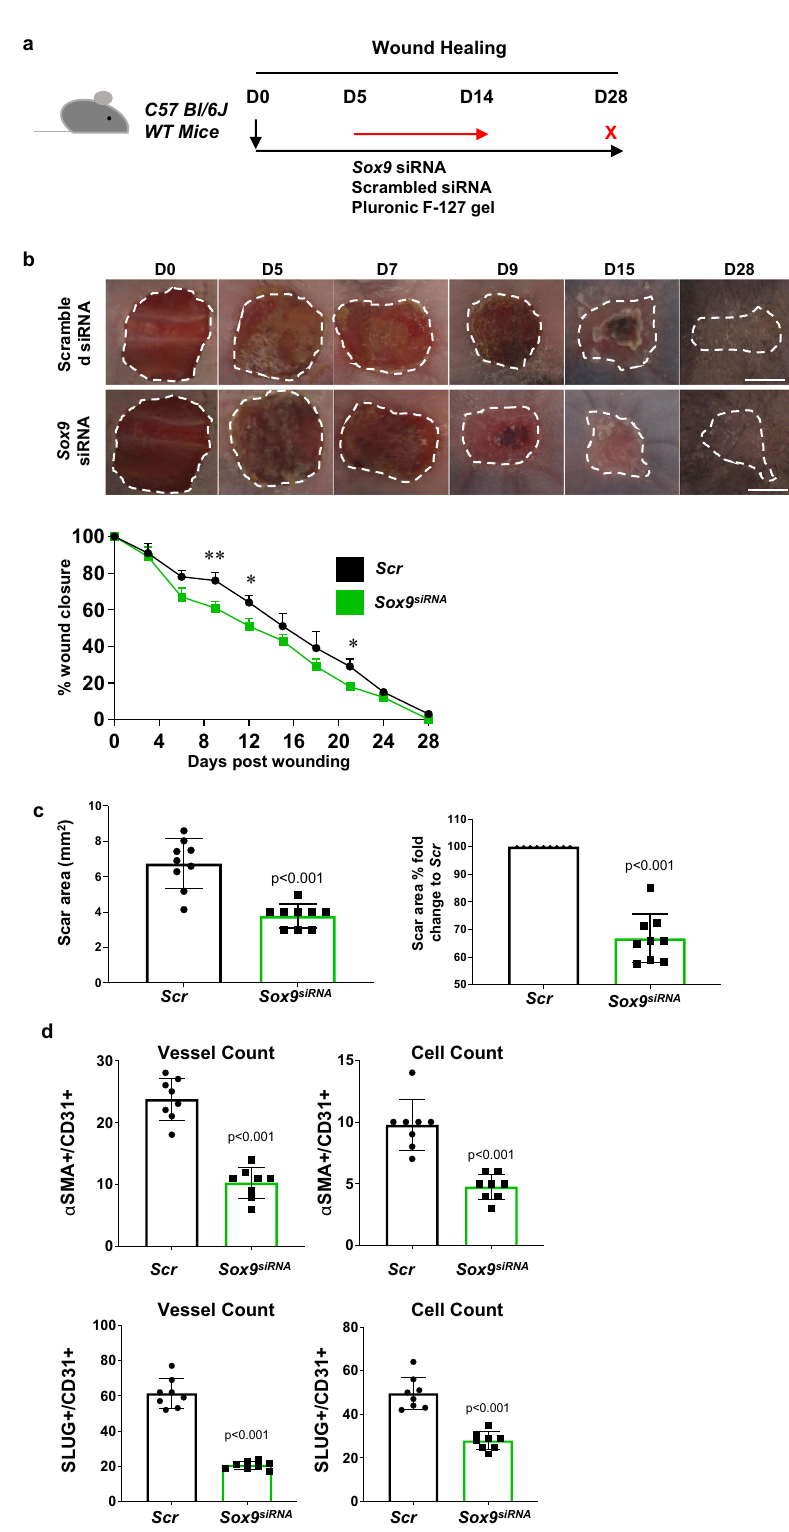
Fig. 8 Reduced scarring upon use of siRNA to inhibit Sox9 in wound healing. a Schematic diagram demonstrating experimental set up using wild-type mice. b Photo images showing wound healing over the course of 28 days (D28) post wounding between scrambled ( Scr ) controls and Sox9 siRNA ( Sox9 siRNA ) treated mice. Signi fi cant increase in wound healing was observed in mice treated with ( Sox9 siRNA ) compared to Scr (* p < 0.05; ** p < 0.01 vs Scr ; n = 8 biologically independent animals; mean ± SD; p value was calculated by two-way ANOVA with multiple comparison of row mean). c Signi fi cant decrease in macroscopic scar area was observed in mice treated with ( Sox9 siRNA ) compared to Scr (** p < 0.01 vs Scr ; n = 8; mean ± SD). d Quanti fi cation of skin wound sections at day 7 (D7) with endothelial markers CD31 and EndMT markers SLUG and α SMA (** p < 0.01; *** p < 0.001 vs Scr ; n = 5 biologically independent animals; mean ± SD; p value was calculated by two-tailed unpaired t